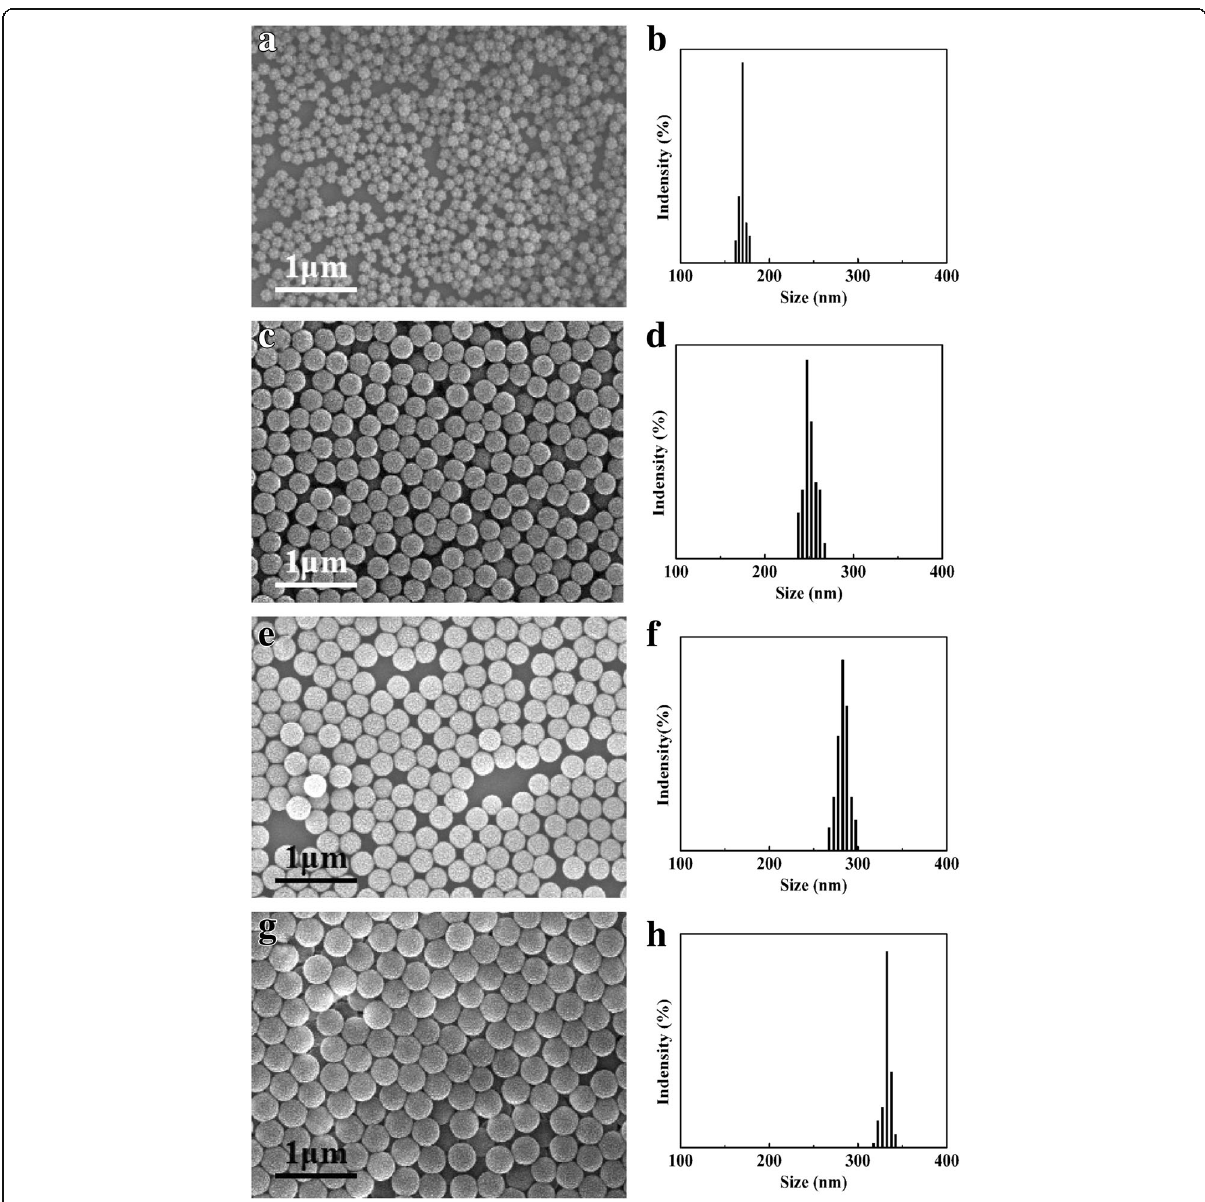
Fig. 1 SEM micrographs and the particle size distribution histograms of PSA nanospheres: a , b PSA1; c , d PSA2; e , f PSA3; g , h